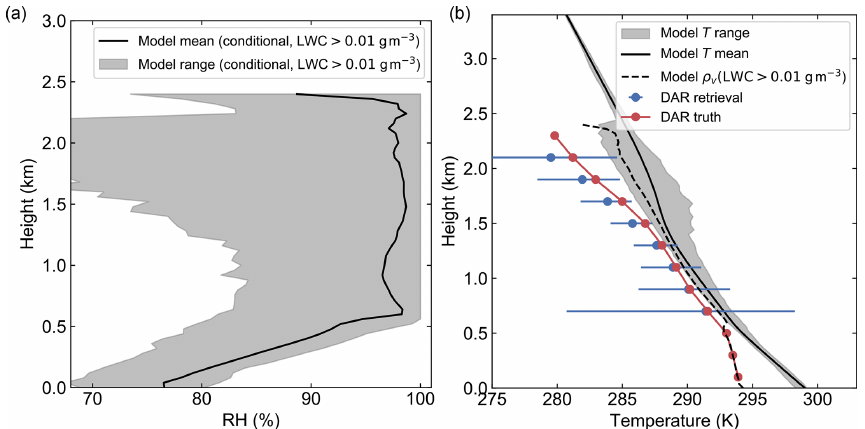
Figure 13. Using DAR humidity observations to estimate temperature profiles in RICO. (a) LES relative humidity profiles conditioned on LWC > 0.01gm − 3 , including the conditional mean (black line) and full model conditional range (gray region). (b) Comparison of model temperature profiles, including the conditional (LWC > 0.01gm − 3 ) mean and full range, with the values inferred from the following profiles assuming saturation: (dashed line) the model humidity profile conditioned on LWC < 0.01gm − 3 , (red circles) the conditionally sampled DAR truth profile from Fig. 5a, and (blue circles) the DAR retrieval from Fig.